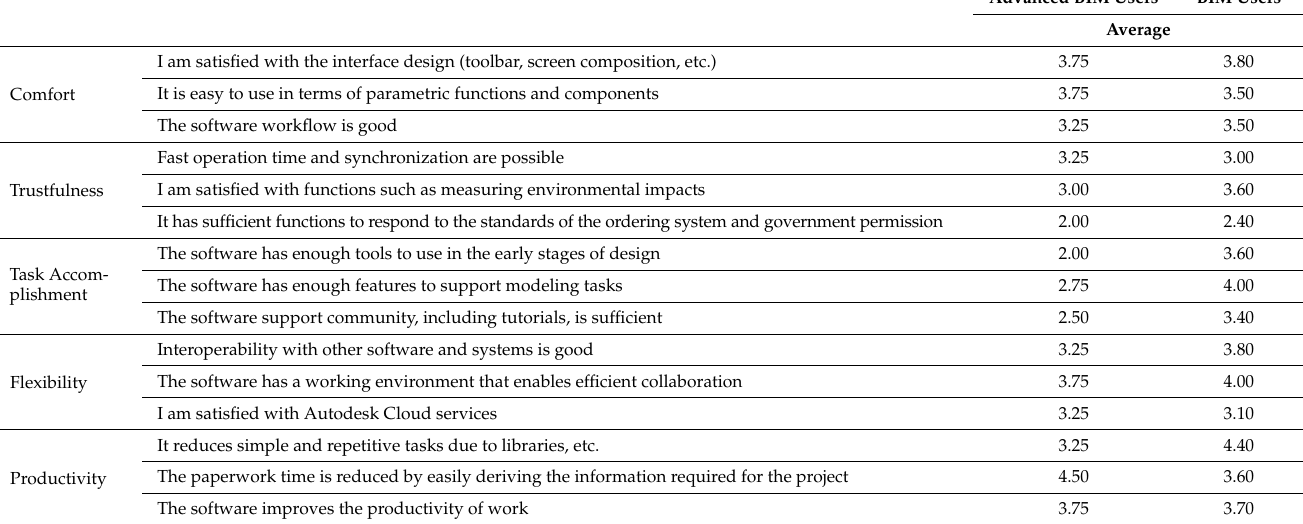
Table 2. Rating for usage of BIM software by